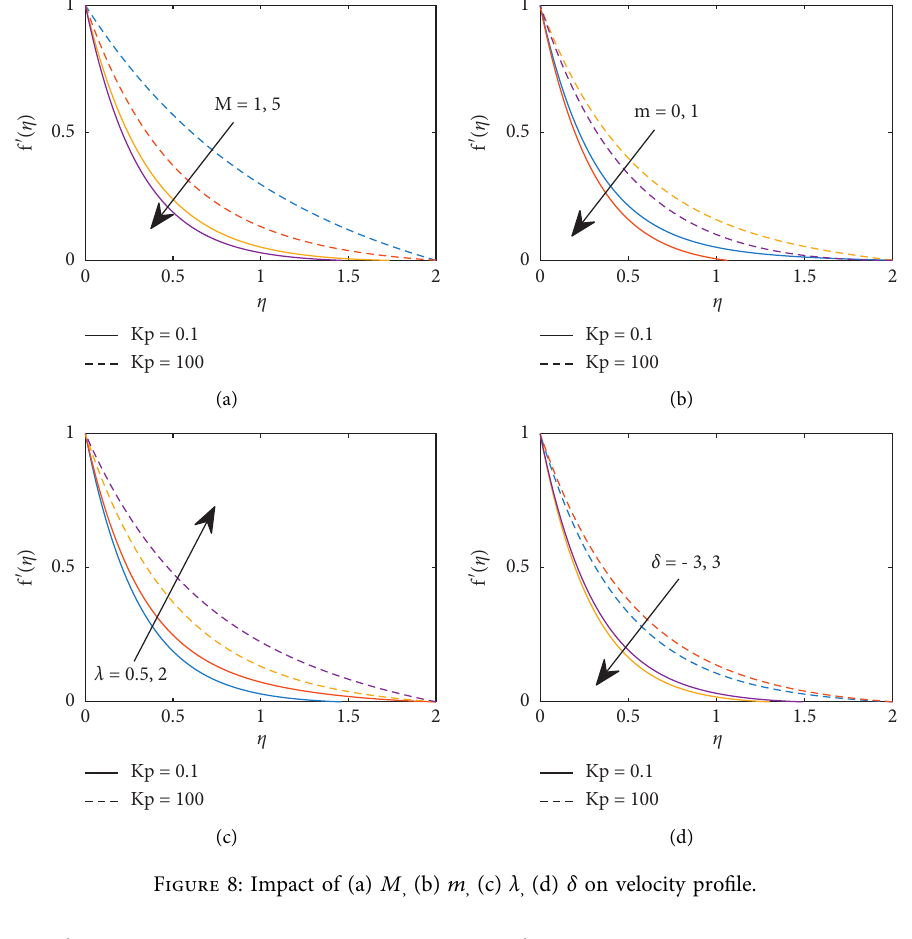
m , (b) , (c) λ , (d) δ on velocity profile.